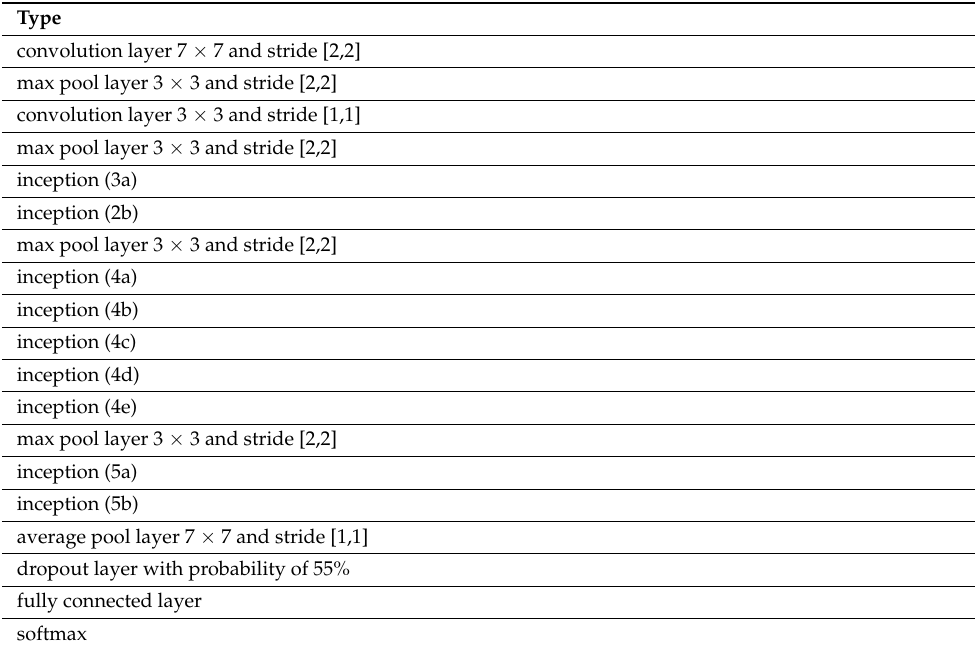
Table 2. Adapted GoogLeNet architecture.